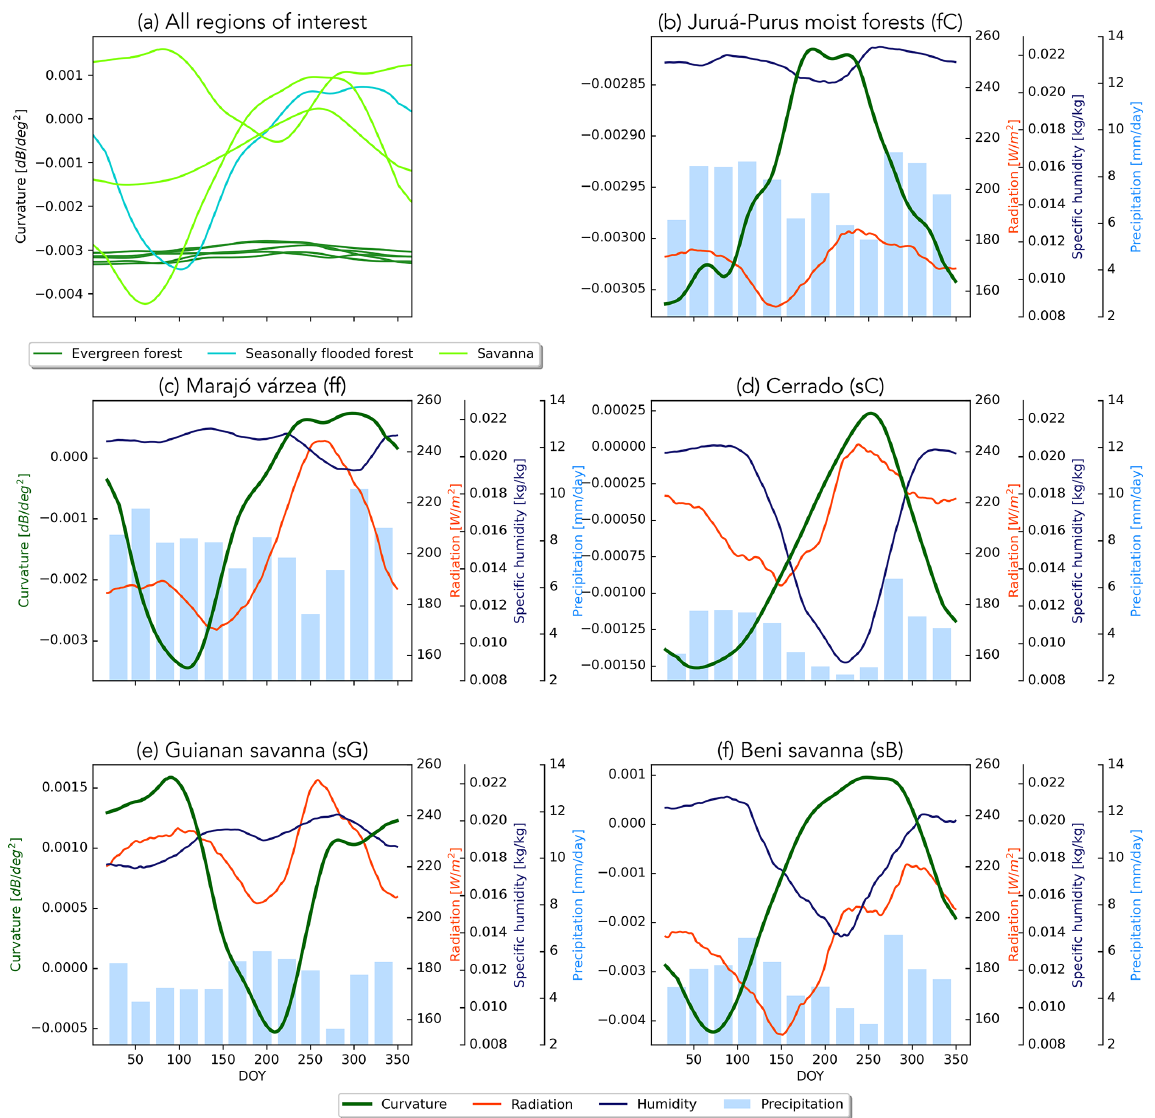
Figure 6. Climatologies of curvature for all ecoregions, with five evergreen forests (dark green), flooded forests (cyan), and three savannas (light green) (a) . Panels (b) – (f) show the climatology of curvature (green line) with precipitation (bars) and specific humidity (blue line) and radiation (red line) per ecoregion. Note the different y axes and that only the Juruá–Purus moist forest (fC) is shown, as it is similar to the other evergreen